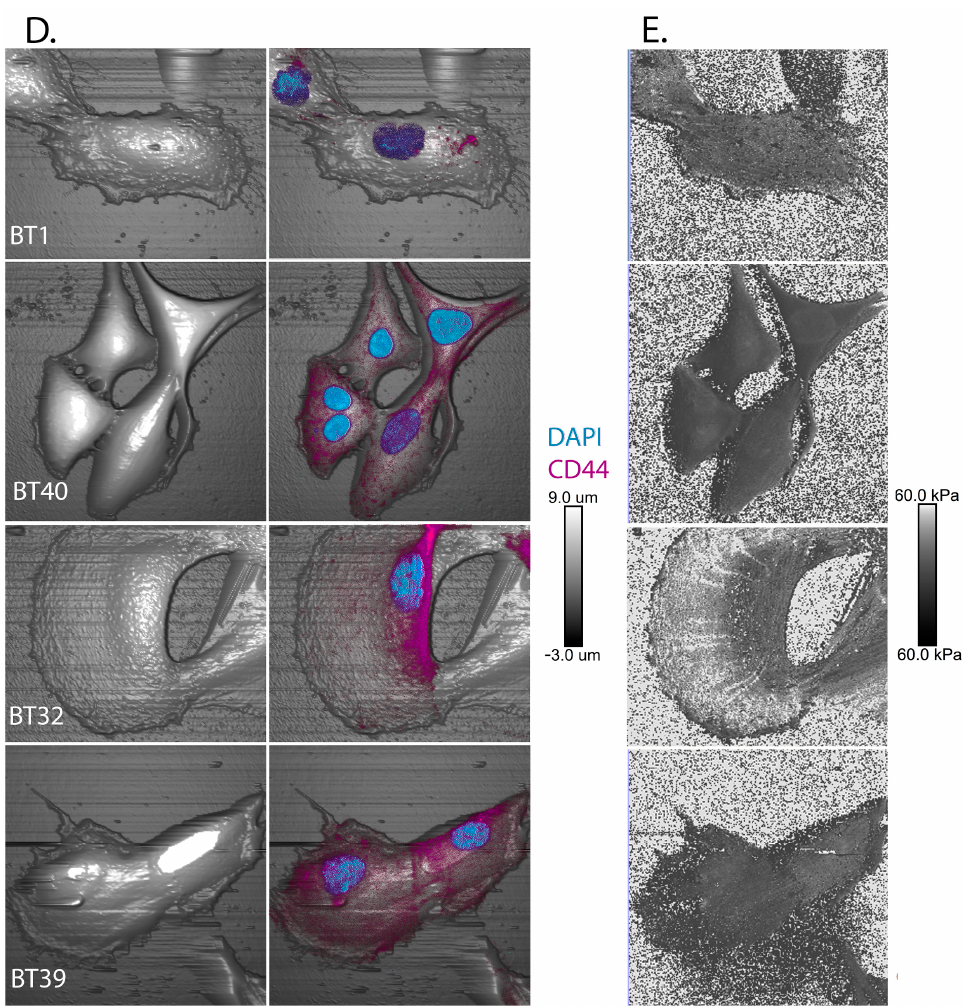
Figure 4. Nanomechanical referent images of each cell culture. Asterisks indicate level of statistical significance: * p ≤ 0.05, ** p ≤ 0.01 and “ns” p > 0.05. ( A ) Atomic force microscopy working principle. ( B ) The distribution of stiffness in cell culture groups depending on their genotype and CD44+/ − ; ( D ) The composite nanomechanical and ICC characterization of cell cultures; ( E ) Young’s modulus mapping of referent cells in each cell